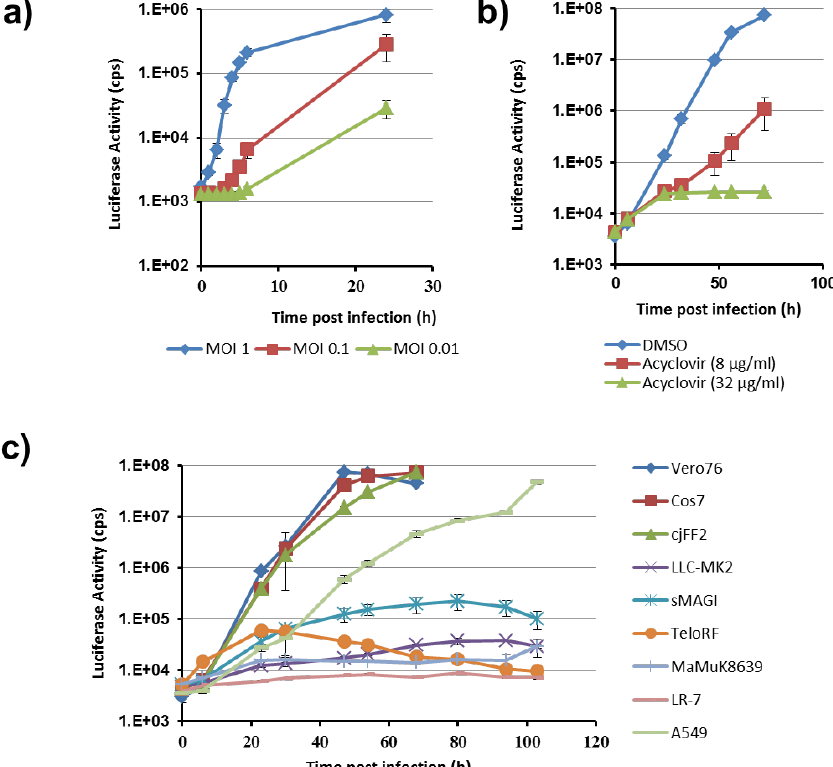
Figure 4. Kinetics of luciferase activity of CeHV-2 ICP4-2A-Gluc in infected cells. ( a ) Vero76 cells were infected at the indicated MOIs with CeHV-2 ICP4-2A-Gluc. Cell culture supernatant was harvested at the indicated time points after infection and luciferase activity determined. The results of a single, representative experiment are shown and were confirmed in a separate experiment. Standard deviation is given for octuplicate samples. ( b ). Multicycle replication kinetics in Vero76 cells infected with low virus dose (100 pfu; MOI 0.0004). Infection and cultivation was done in the medium containing acyclovir or solvent (DMSO). Aliquots of cell culture supernatant were continuously harvested over 3 days followed by measurement of luciferase activity. The results of a single, representative experiment carried out with triplicate samples are shown and were confirmed in a separate experiment. Error bars indicate SD. ( c ) Multicycle replication kinetics on cell lines derived from di ff erent species. Cells were infected with low virus dose (100 pfu; MOI 0.0004) and aliquots of cell culture supernatant continuously harvested over 5 days followed by measurement of luciferase activity. The results of a single experiment carried out with triplicate samples are shown and are representative of a total of 2–4 separate experiments. Error bars indicate standard deviation